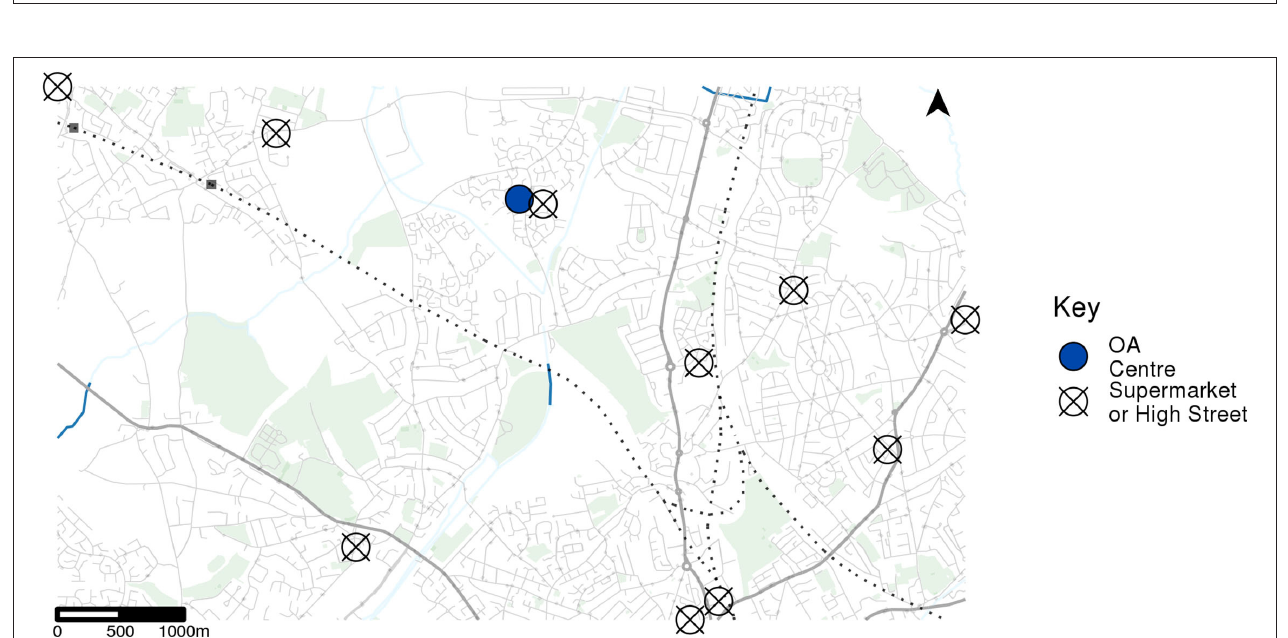
FIGURE 4 | Example census output area (OA) centroid and 10 nearest retail location centroids.